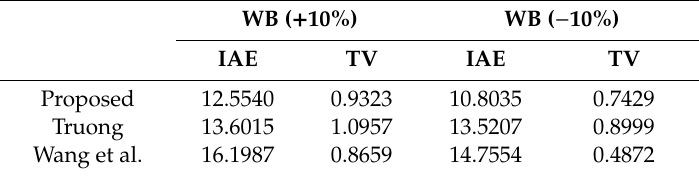
Table 5. Robustness analysis for the WB column under ±10% parametric uncertainty in all parameters.